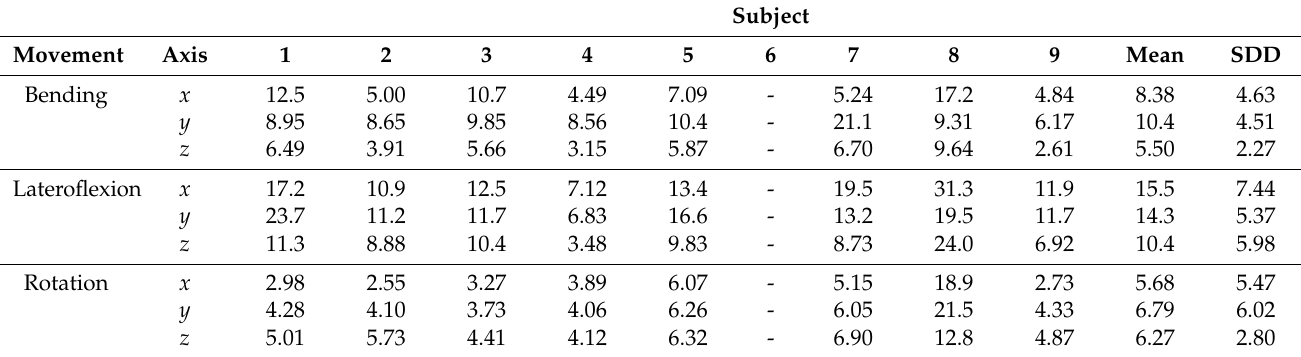
Table 3. RMSE between the ANN-based method and the biomechanical model. The root means square error (RMSE) between the net moment curves at L5/S1 was estimated by the ANN-based method and the LSM-based method. Values are shown for the three movements trunk bending, lateroflexion and rotation with the anterior–posterior axis ( x ), mediolateral axis ( y ) and longitudinal axis ( z ). Shown are individual values for each subject plus the mean and standard deviation (SDD) over all subjects. No valid data were obtained for subject number 6 for reasons of partially missing data in the 6 kg